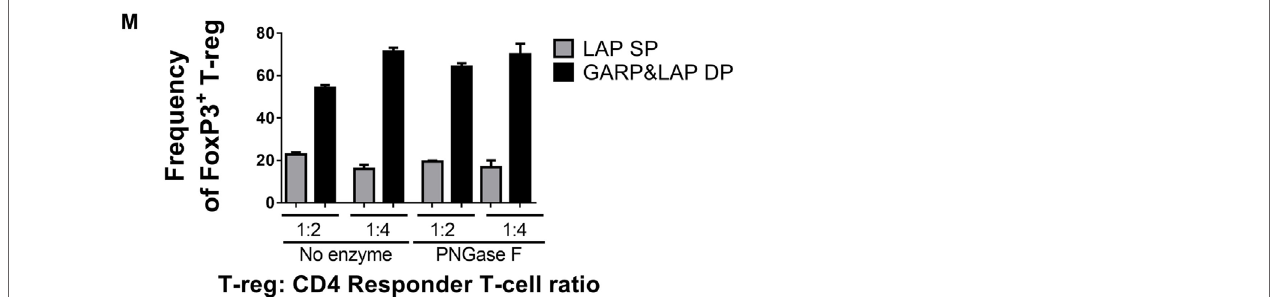
FigUre 5 | Surface Griffonia simplicifolia lectin I (GSL-I) and Phaseolus vulgaris leucoagglutinin (PHA-L) binding, viability, and responsiveness to stimulus of PNGase F-treated Treg. (a–D) Flow cytometry (FCM) histogram overlays and graphs of median fluorescence intensity (MFI) of GSL-I (a,c) and PHA-L (B,D) binding to freshly isolated Treg, Treg incubated in culture medium alone (Untreated), Treg incubated in enzyme buffer alone (no enzyme) and Treg incubated in enzyme buffer containing PNGase F. For the latter three, analyses were performed immediately after incubations. (e) Frequencies of viable Treg after 24 h coculture with antigen-presenting cells (APCs) with and without anti-CD3 activation assessed by FCM using SYTOX ® AADvanced dead cell stain. (F–M) Treg were cocultured with CD4 + Tconv at 0:1, 1:2, and 1:4 Treg: responder T-cell ratios in the presence of APCs and anti-CD3 activation for 24 h, after which (F) the frequency of viable Treg and (g–M) Treg expression of several surface proteins were evaluated. Graphs show surface expression levels (MFI) of (g) CD25, (h) CD69, (i) PD-1, (J) GARP, (K) LAP, and (l) complex tri/tetra-antennary N -glycans (PHA). (M) Frequency of LAP single positive (LAP SP) and GARP and LAP double positive (GARP&LAP DP) Treg after 24 h coculture. (a–D) Data are representative of one of five separate experiments. (e–M) Data represent mean ± SD ( n = 3 technical replicates). Statistical analysis was performed by permutation test with an unpaired design (* p value ≤ 0.1; ** p value <